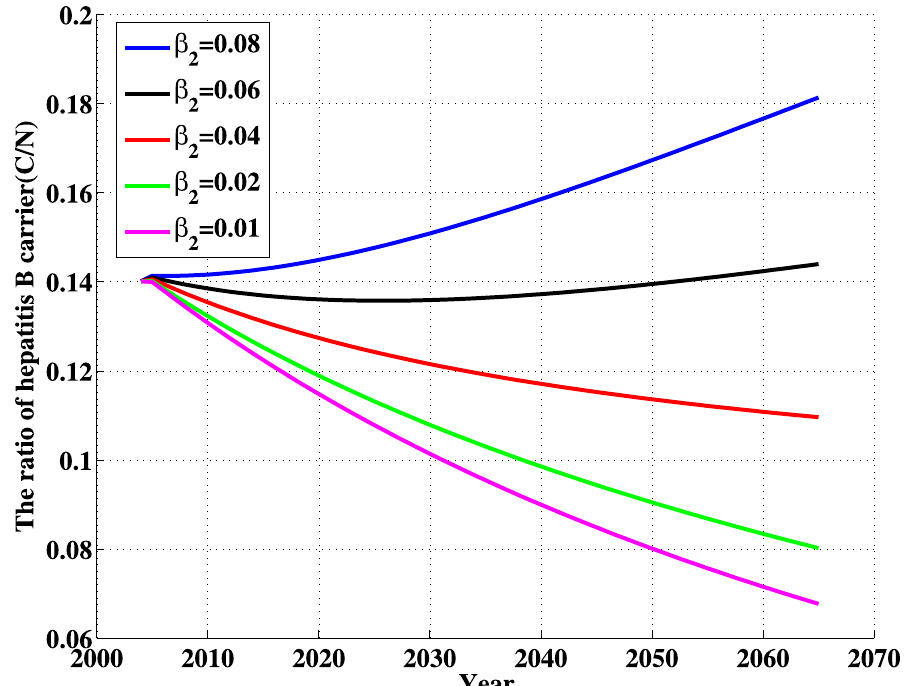
Fig 8. The influence of the parameter β 2 on the ratio of hepatitis B carrier ( C values of β 2